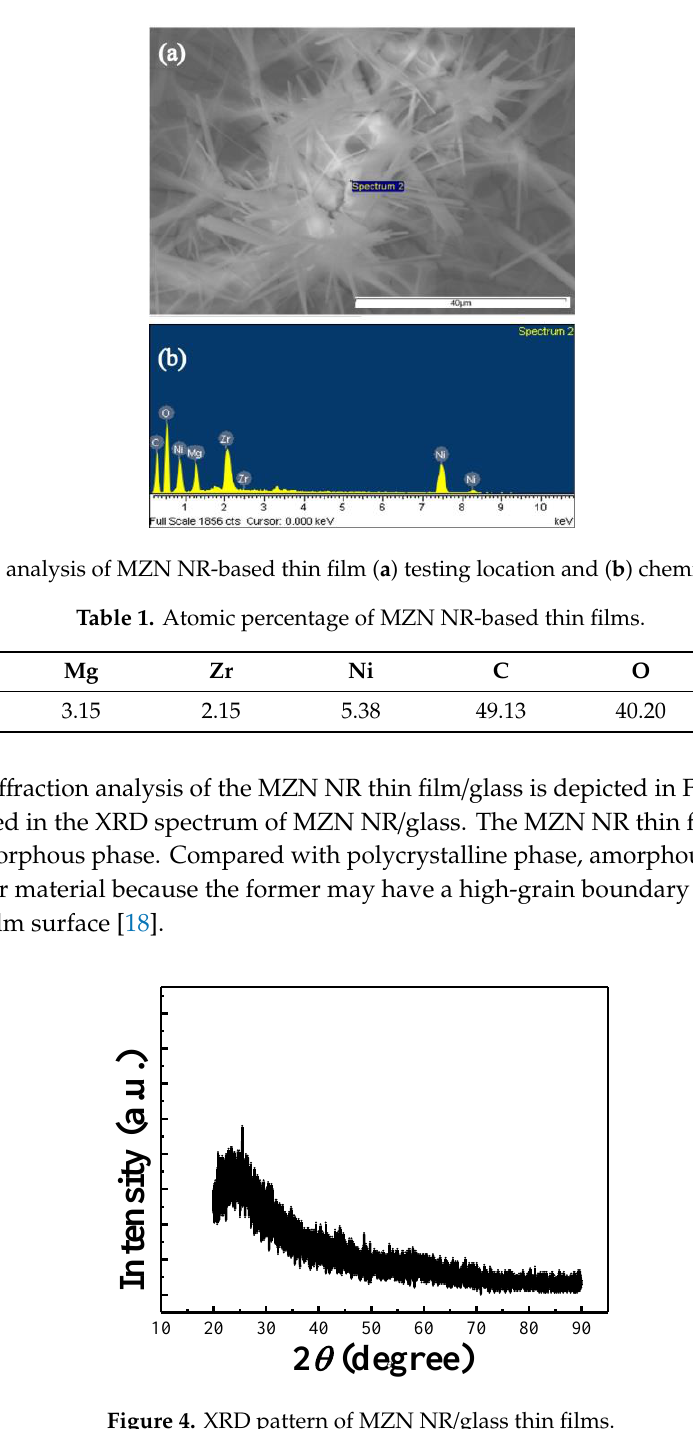
Figure 4. XRD pattern of MZN NR/glass thin films.